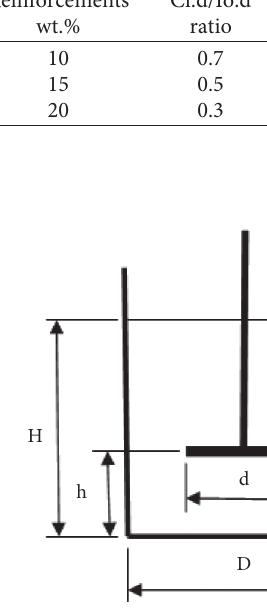
Figure 12: Stirrer to the crucible ratio dimension [53].